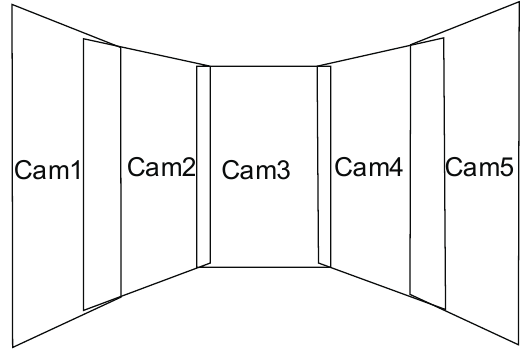
Figure 5. The scheme of rectification of oblique images.